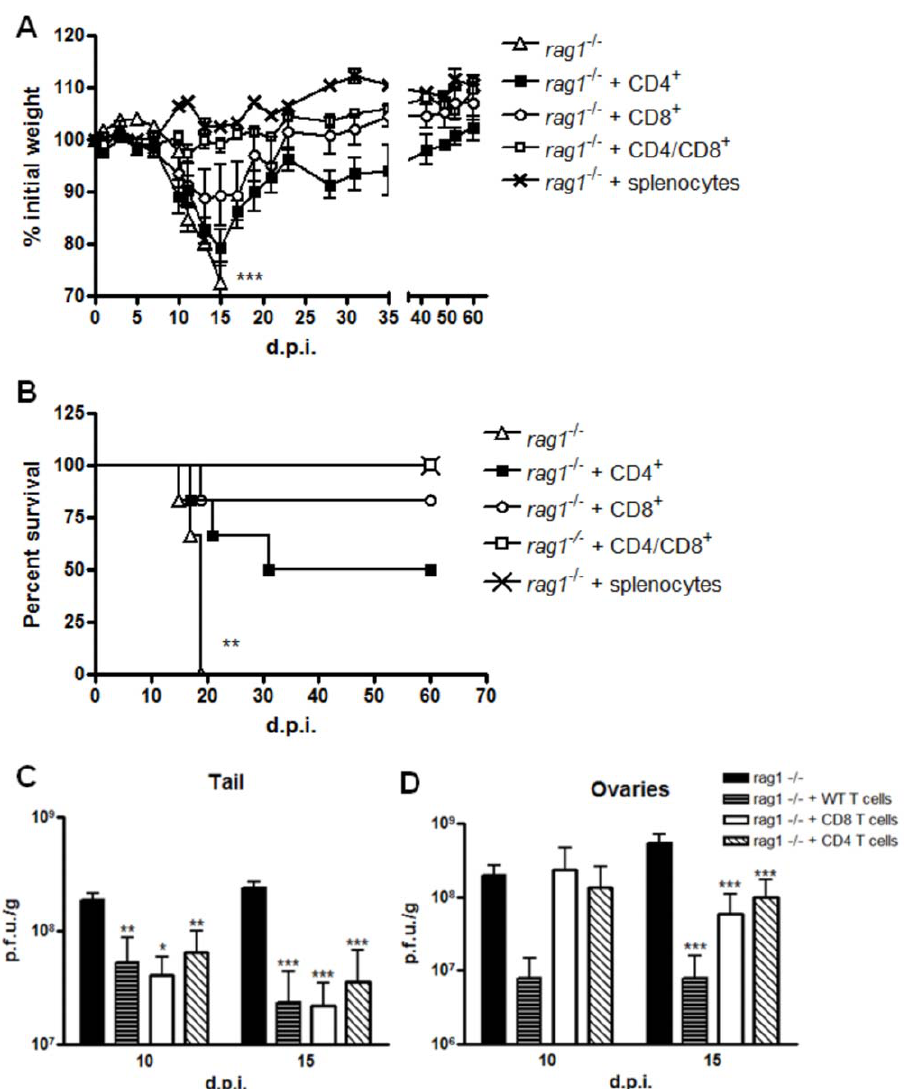
Figure 7. Rag1 2 / 2 mice passively transferred with both T cells were fully protected from VACV infection. Spleens of naı¨ve C57BL/6 mice were removed and made into single-cell suspension and this population was enriched in CD4 + and CD8 + T cells using a negative selection system. ( A ) Rag1 2 / 2 were inoculated intravenously with either CD4 + and CD8 + T cells or either type alone ( n =6 per group). As a control, Rag1 2 / 2 mice received splenocytes prior to isolation intravenously (10 7 viable cells). Four days after inoculation, all animals were infected with VACV-WR by tail scarification and weighted daily (*** p , 0.001, paired t test). Bars represent mean and SEM. ( B ) Survival curve of Rag1 2 / 2 passively transferred with both CD4 + and CD8 + T cells or with either type alone, compared to the mortality in the same strain without previous treatment (** p , 0.01, log-rank test). Viral titers in tail ( C ) and ovaries ( D ) of mice passively transferred with WT T cells and infected with VACV-WR. Bars represent mean and standard error (SEM) (* p , 0.05, ** p , 0.01 and *** p , 0.001 compared to Rag1 2 / 2 non-treated group, t test). The results shown are representative of two experiments (CD4 + plus CD8 + T cells group). For animals that received only CD4 + or CD8 + T cells, only one experiment was performed.